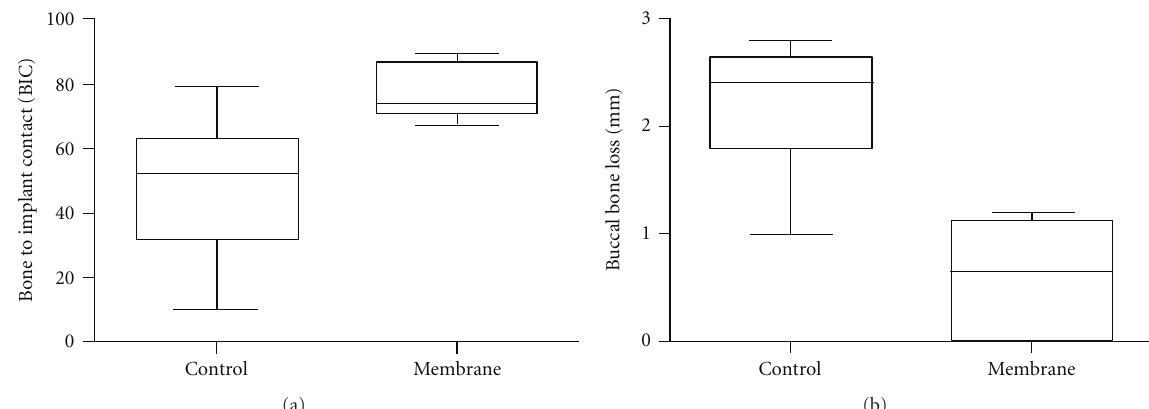
Figure 6: Wilcoxon matched paired test revealed (a) significant higher BIC to the experimental group ( P < 0 . 02), and (b) significantly lower buccal bone loss for the membrane group compared to the control group ( P < 0 .